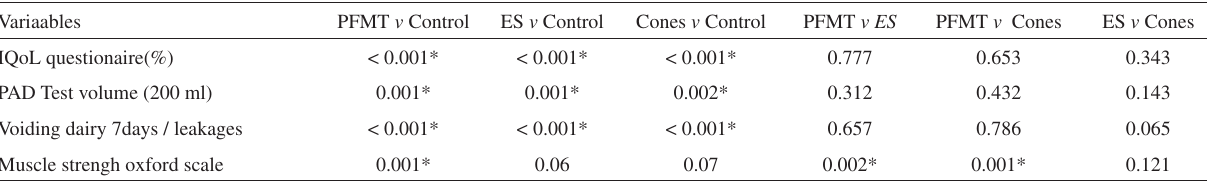
Table 3 - Outcome measure and multiple comparison of all groups at 6 months